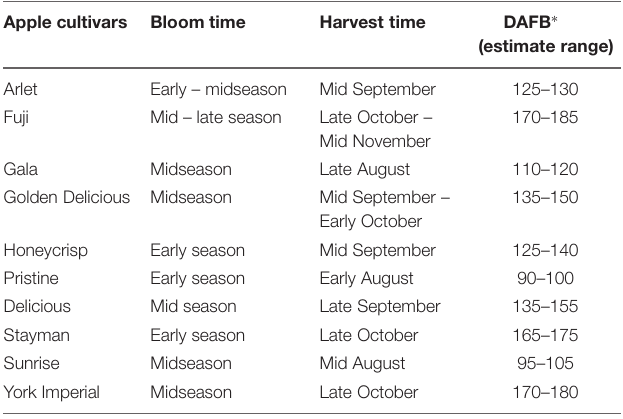
TABLE 1 | Description of bloom time, harvest time and an estimated range of fruit maturity in terms of days after full bloom of apple cultivars used in multiple-choice and no-choice